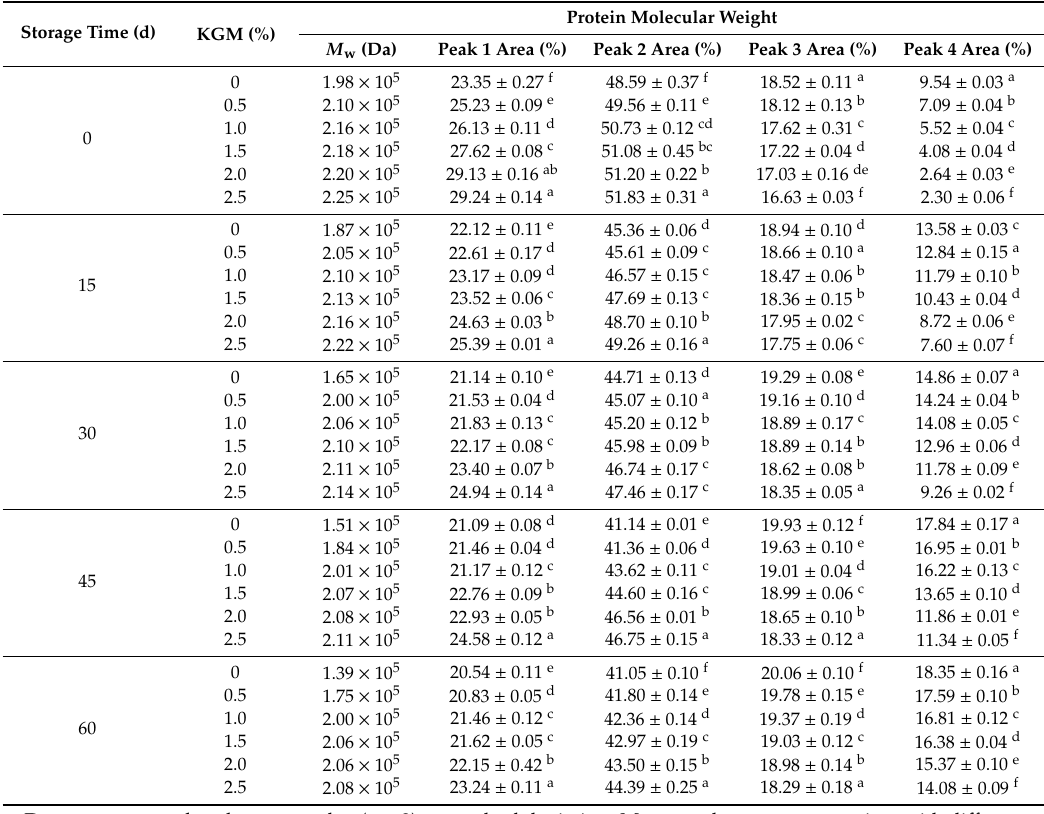
Table 1. Effect of different proportions of KGM added to the molecular weight of frozen dough. Storage